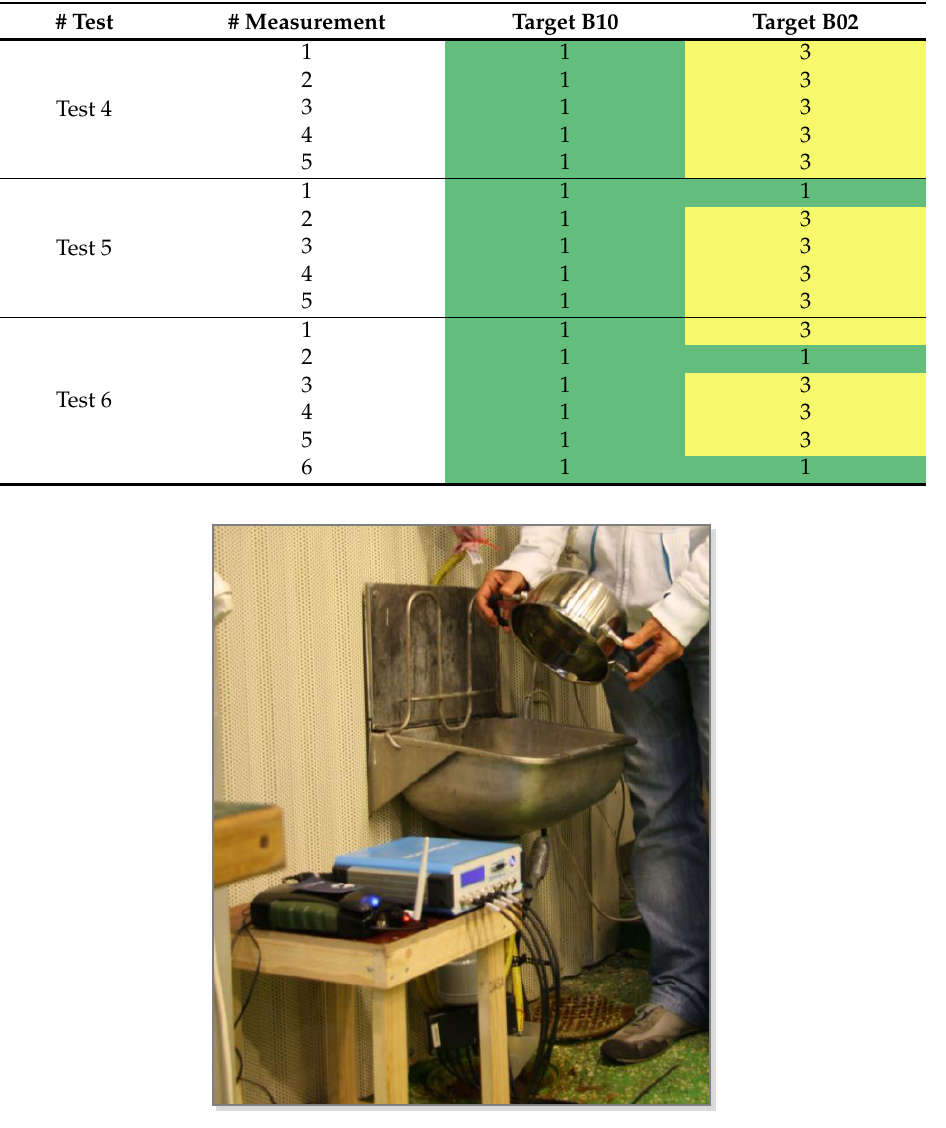
Table 12. Results obtained for the EC sensor during the tests performed during the final demonstration at FOI.